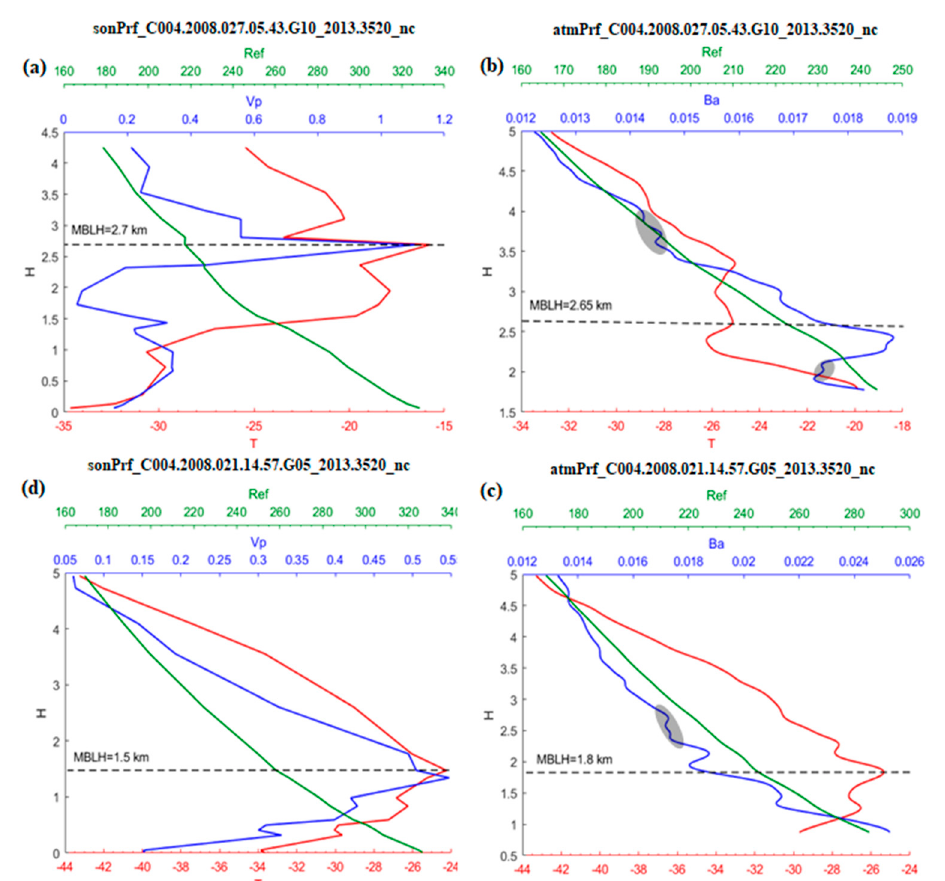
Figure 2. ( a , c ) are sonprfs, ( b , d ) are atmprfs. ( a , b ) matched at (67.3 ◦ N, 87.9 ◦ W); ( b , d ) matched at (79.2 ◦ N, 59.3 ◦ W). Ref, VP, T, Ba denotes refraction, vapor, temperature, bending angle, respectively. The dashed line represents the height of the inversion layer in the temperature profile. The elliptical shaded region represents the high frequency part of the occultation bending angle profile.